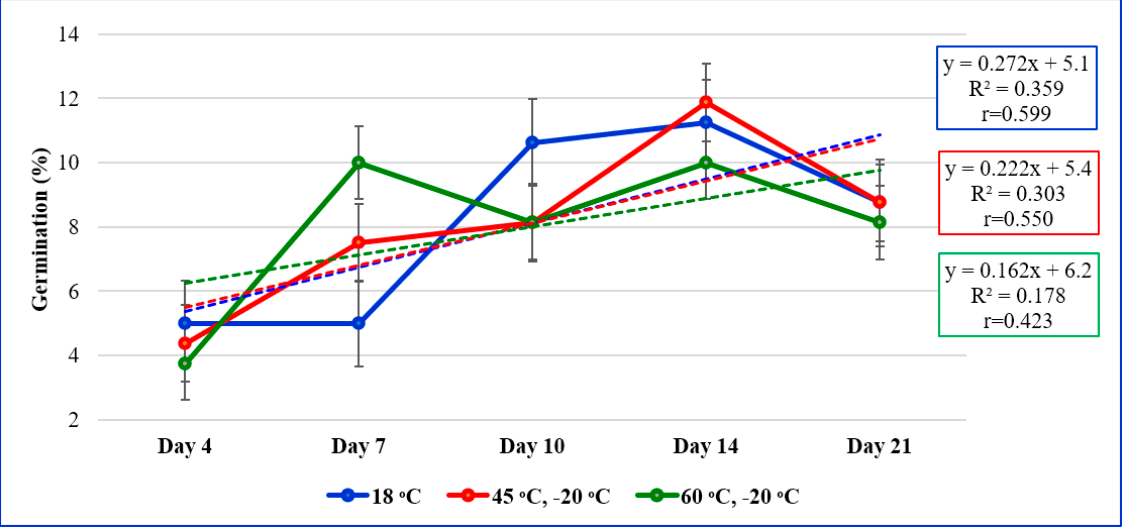
Figure 4. Black locust seed germination (%) evolution in days, depending on the thermal treatments applied with three different levels.